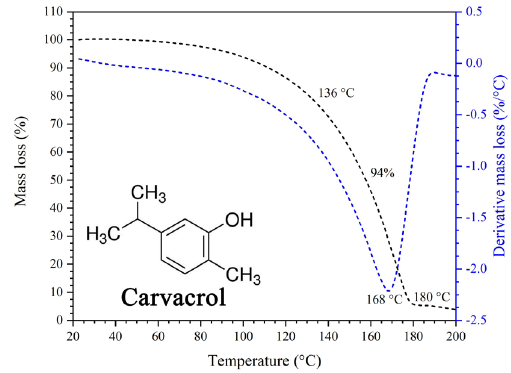
Figure 2. TGA and DTGA curve of